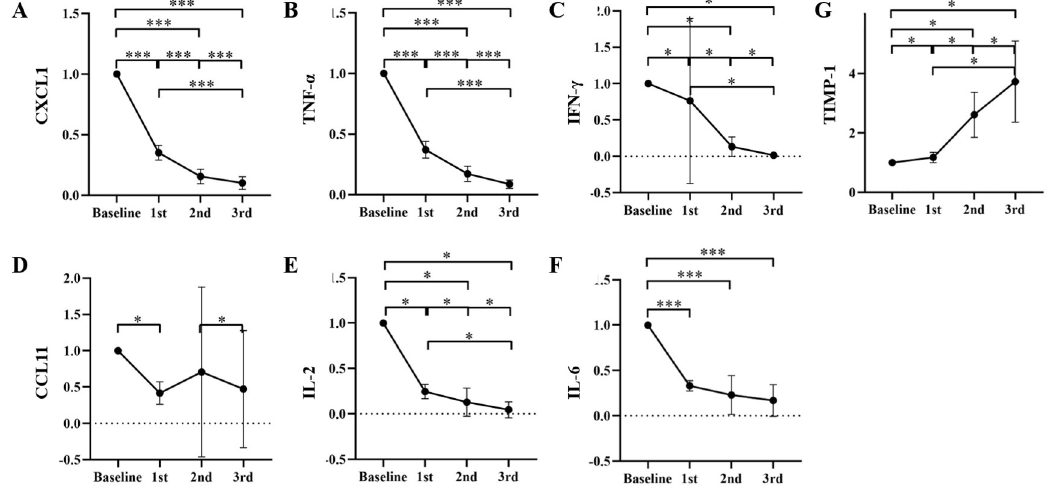
Fig 2. Change in tear cytokines following each IPL treatment session as a ratio compared with the pretreatment baseline. (A) CXCL1, (B) TNF- α , (C) IFN- γ , (D) CCL11, (E) IL-2, (F) IL-6, (G) TIMP-1. � P < 0.05, ��� P < 0.001.